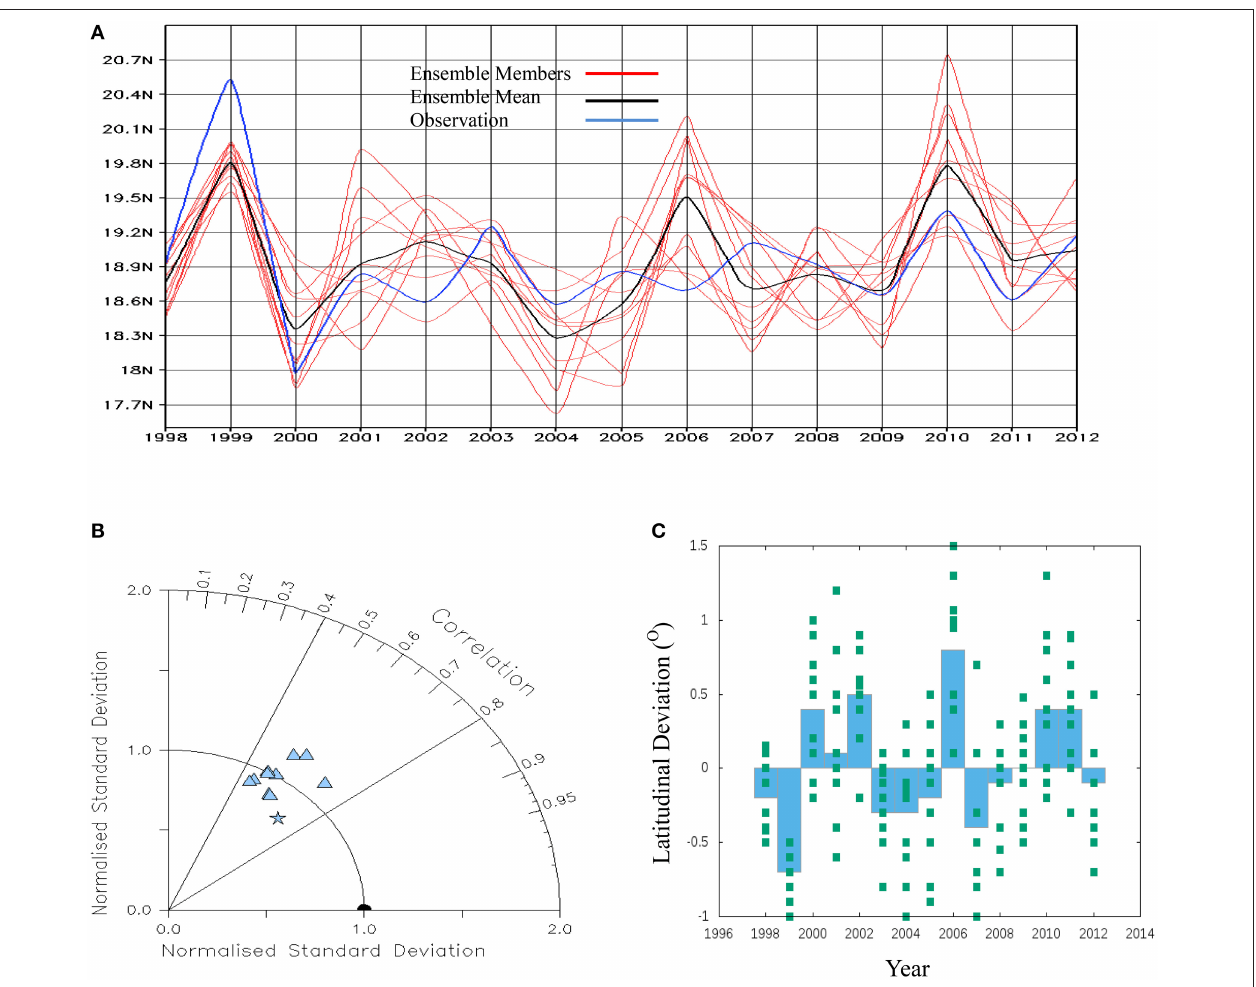
FIGURE 4 | (A) Inter-annual variability of the latitudinal position of ITD ( ◦ N) over Nigeria during the peak of the monsoon (August) by the ensemble members (red-lines), the ensemble mean (black-line) and observed Era-Interim (blue-line); (B) Taylor diagram showing the normalized standard deviations and the correlation coefficients of S2S ensemble simulations with observation for panel a (ensemble members—blue triangle; blue circle for negative correlations), ensemble mean—blue star and Era-Interim (observation)—black semi-circle. The normalized standard deviations and correlations are with reference to Era-Interim over same area; and (C) Latitudinal deviation of the predicted ITD from the observed (Era-Interim) ITD as displayed by the ensemble mean (blue-bar) and the ensemble members (green squares).